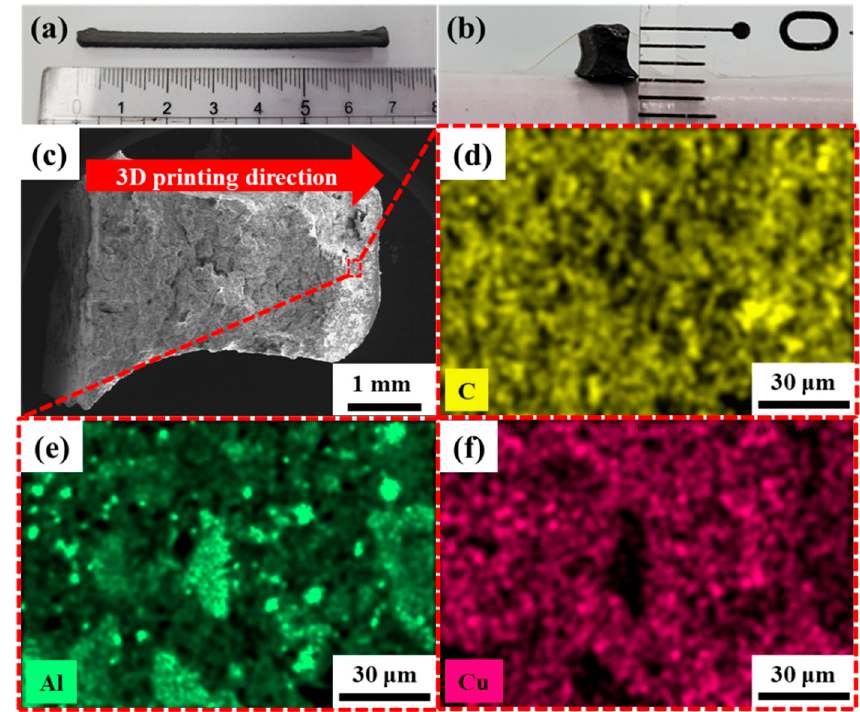
Figure 3. Photographs of the ( a ) top and ( b ) cross-sectional views of PEO/nEM (PEO:nEMs = 10:90 wt.%) composite-based 3D-printed rod structure. ( c ) Low-resolution SEM image of cross-sectional area of PEO/nEM composite-based 3D-printed rod, and the elemental mapping images of ( d ) carbon (C), ( e ) aluminum (Al), and ( f ) copper (Cu) elements, respectively, at a specific area of the cross-section of the PEO/nEM composite-based 3D-printed